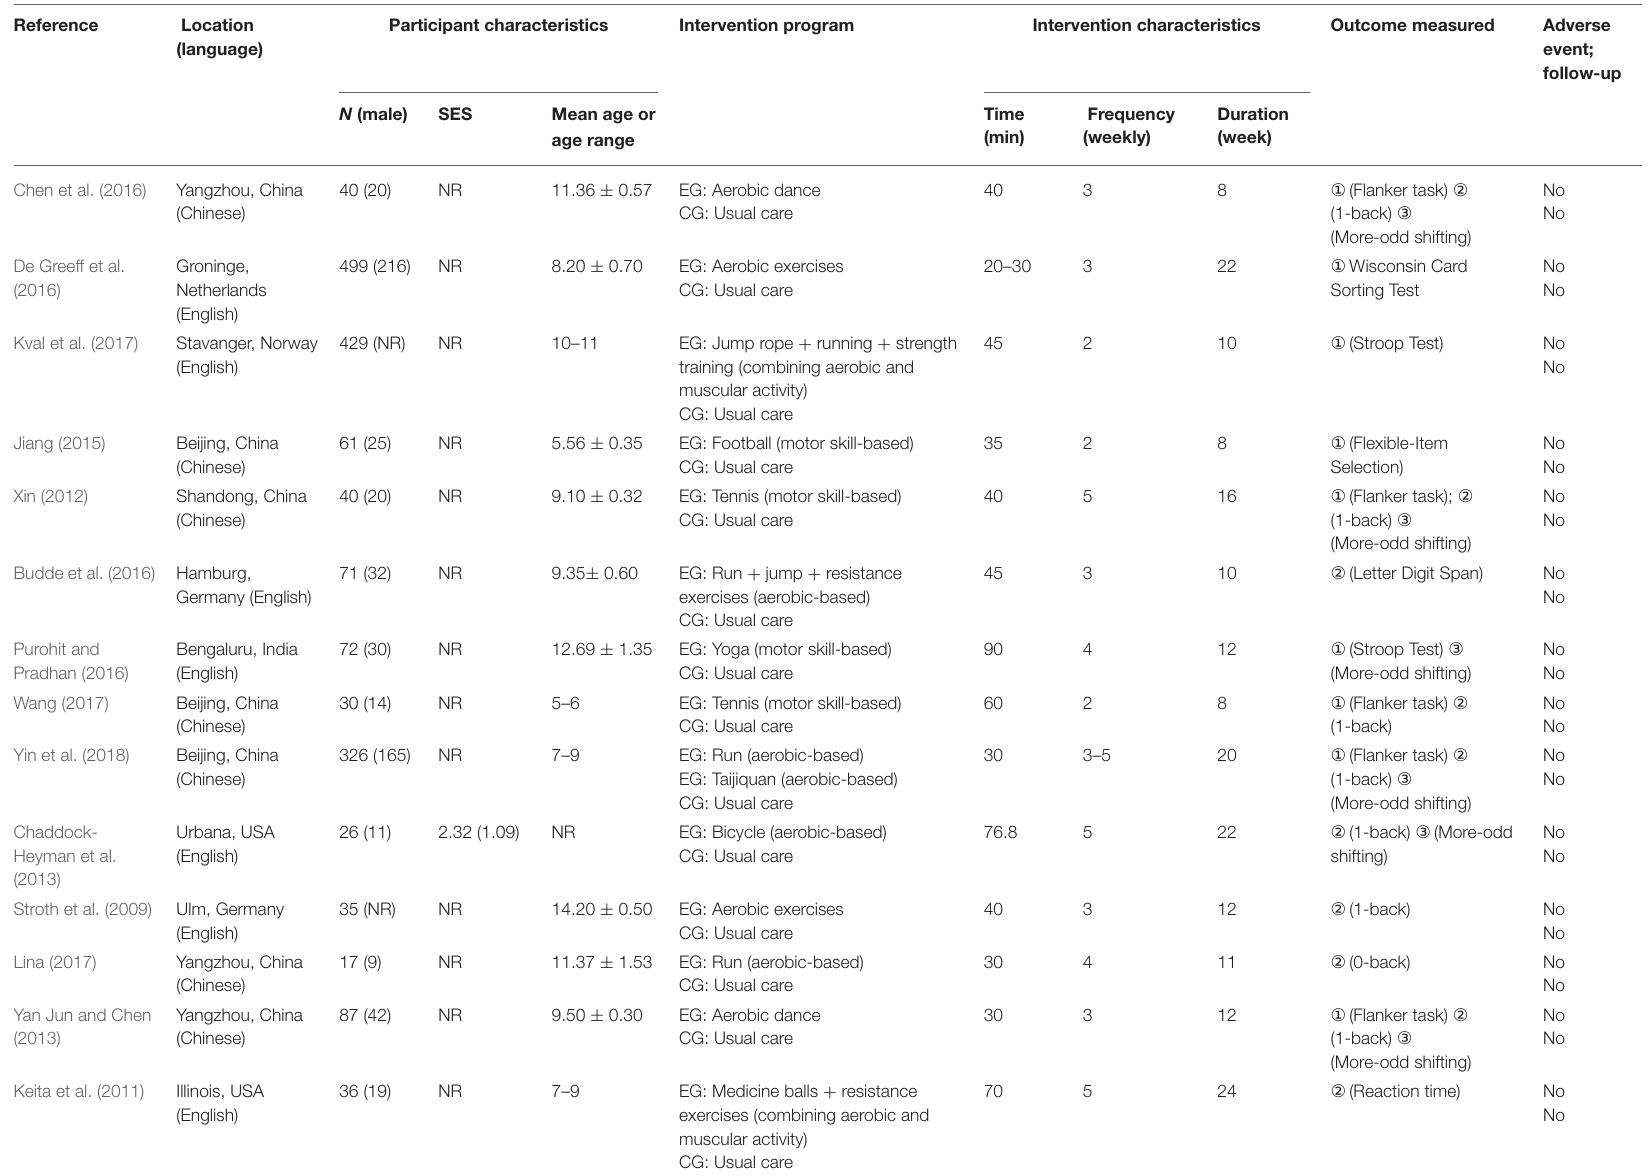
TABLE 2 | Characteristics of the studies included in the meta-analysis (chronic